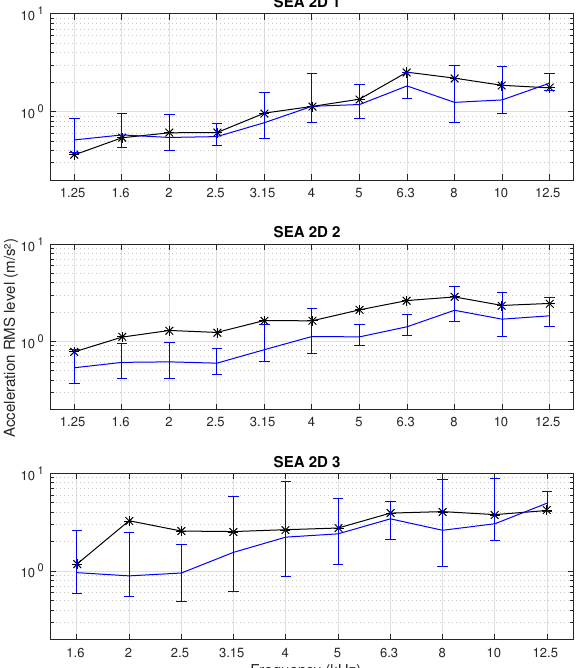
Figure 19. Test (black lines with stars) -simulation (blue lines) comparison for one-third octave band mean acceleration in the three SEA subsystems. The simulation spread displayed is obtained varying the damping loss factor in accordance with measurements shown in Figure